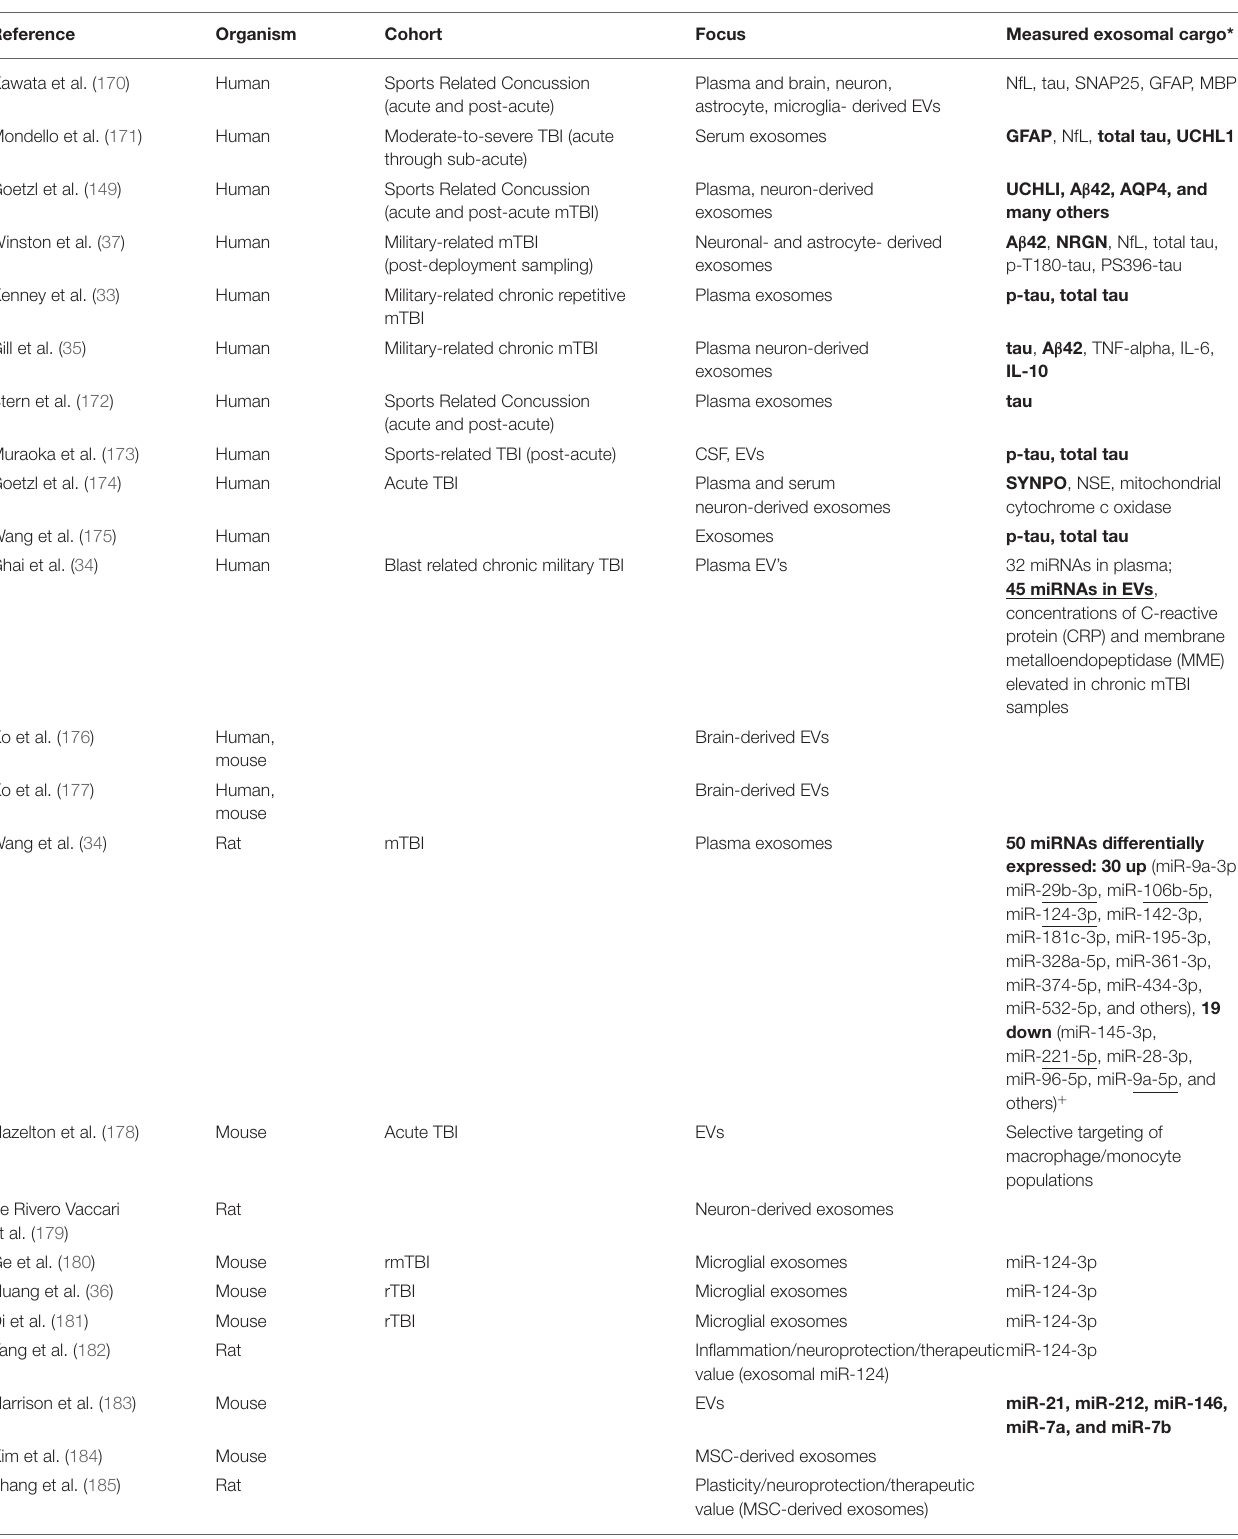
TABLE 1 | Extracellular vesicles studies in traumatic brain